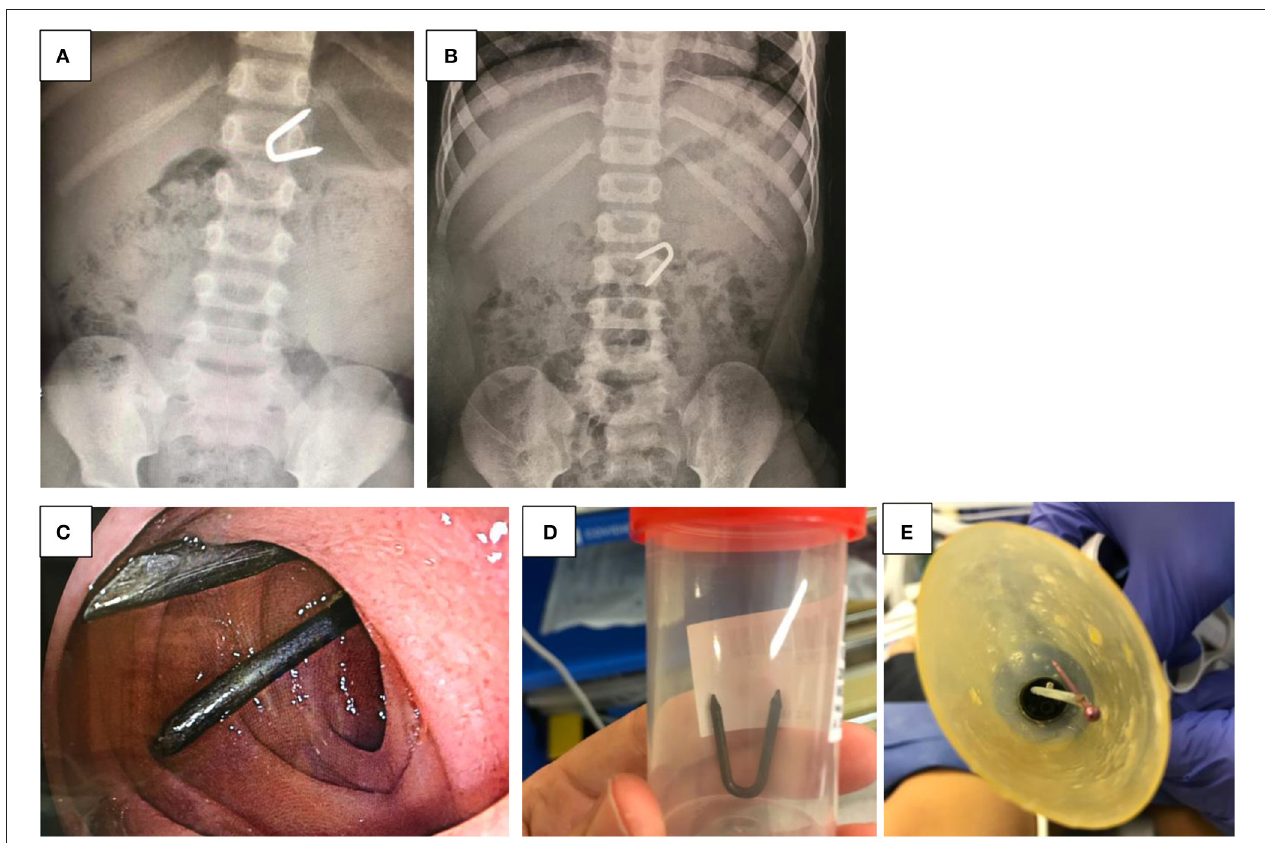
FIGURE 4 | (A–E) Ingestion of a pointed foreign body. (A,B) . Abdominal x-ray of a pointed foreign body ingested by a 5-year old child. (C) Foreign body in the mid-duodenum. (D) FB after successful extraction with a retrieval forceps. (E) Foreign body (pin to fasten clothing) which has been grasped via a polypectomy snare and withdrawn into a protector